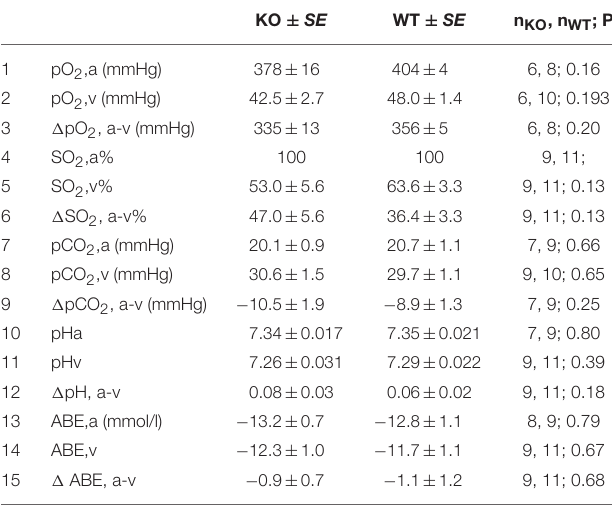
TABLE 3 | Specific oxygen consumption of AQP1-KO and WT mice under 40 ng/g/min